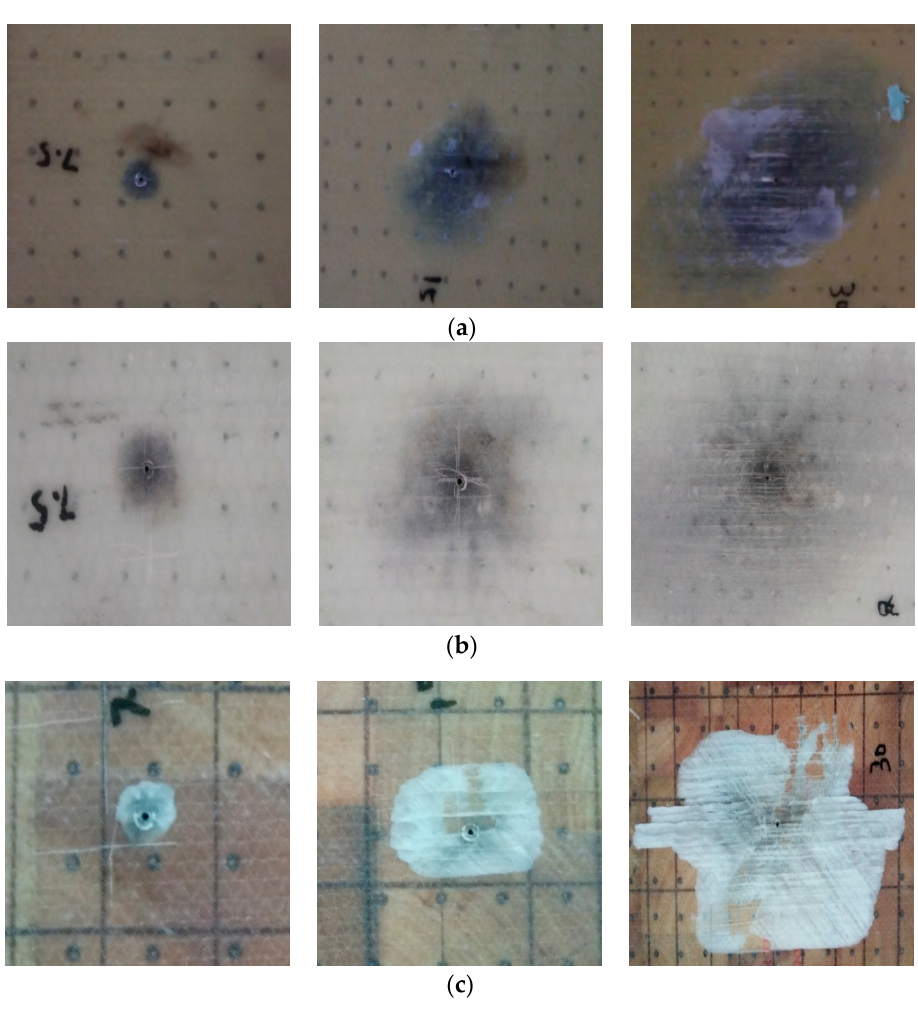
Figure 4. Damage morphology of samples: ( a ) PVC; ( b ) PET; ( c ) balsa wood.